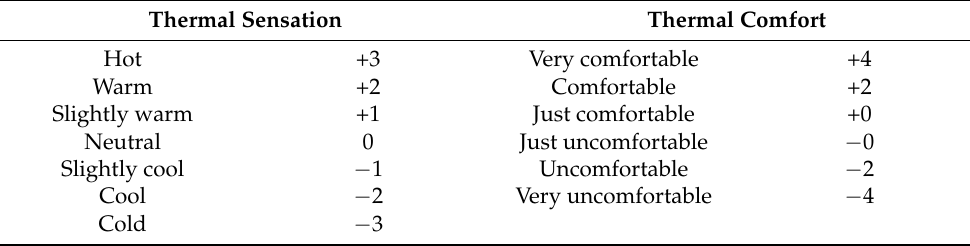
Table 3. Scale summary.